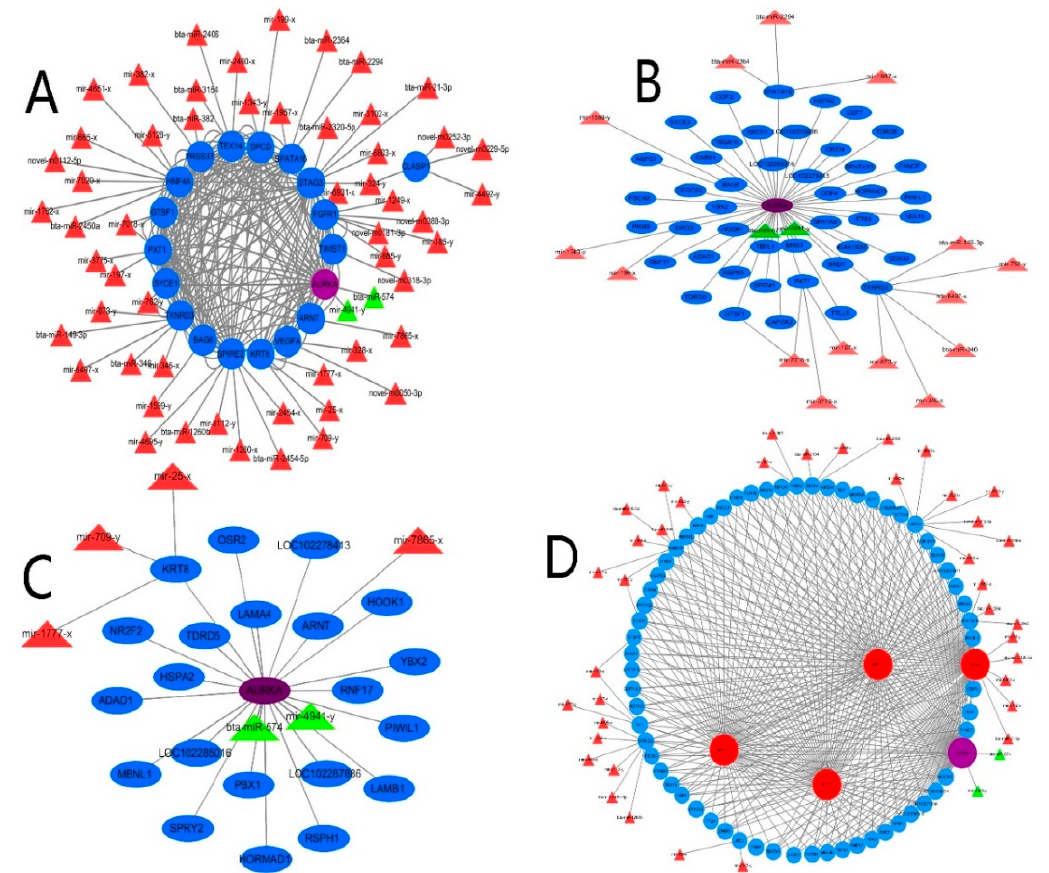
Figure 5. Integrated network analysis of different expressed microRNAs /messenger RNA. ( A ) The paired microRNA–messenger RNA interaction relationships of 93 DEGs and 589 DE microRNAs were used for creating an integrated network. ( B ) Only three in 38 candidate DEGs were potentially regulated by six microRNAs ( ρ > 0.8) in testis development. Twenty-one DEGs have a close relationship compared with AURKA ( r > 0.9). ( C ) In spermatogenesis, we identified seven out of 46 candidate DEGs that were potentially regulated by 17 microRNAs ( ρ > 0.8). ( D ) There were 13 out of 68 candidate DEGs that were potentially regulated by 40 microRNAs ( ρ > 0.8) in reproduction. Sixty-six DEGs had a close relationship, compared with AURKA ( r > 0.9).